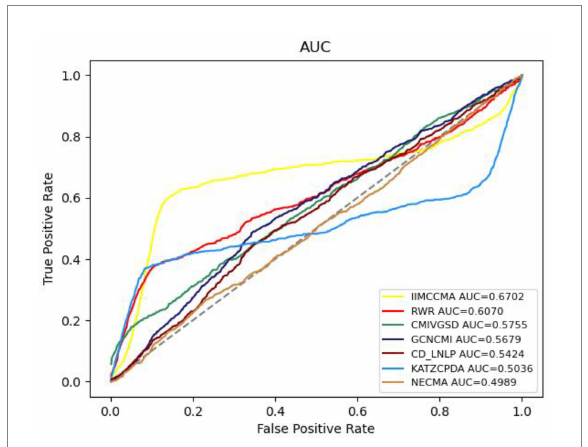
FIGURE 2 Performance comparison between IIMCCMA and other models on dataset 1 in term of AUROC.